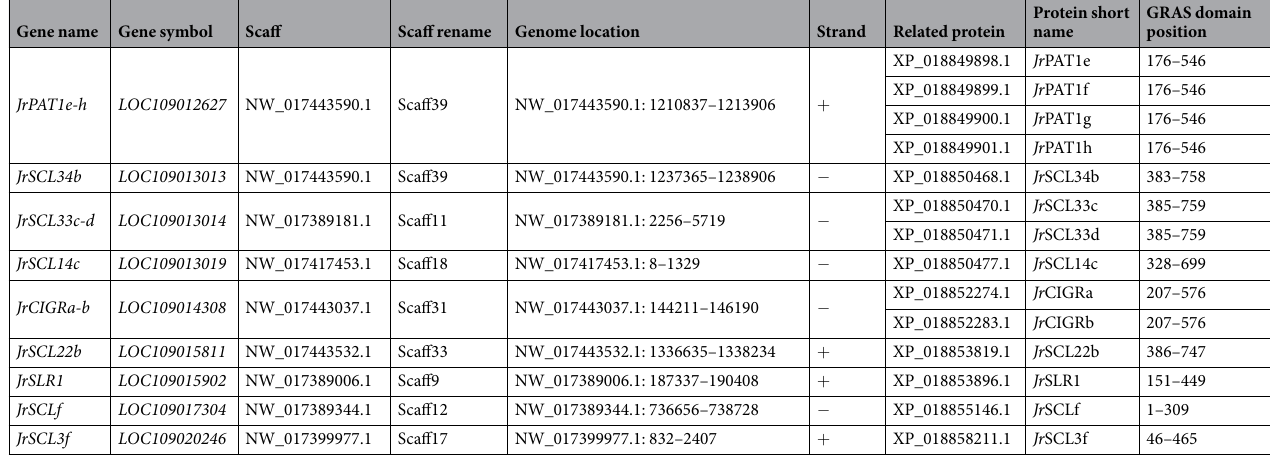
Table 1. GRAS gene family identified in Juglans regia